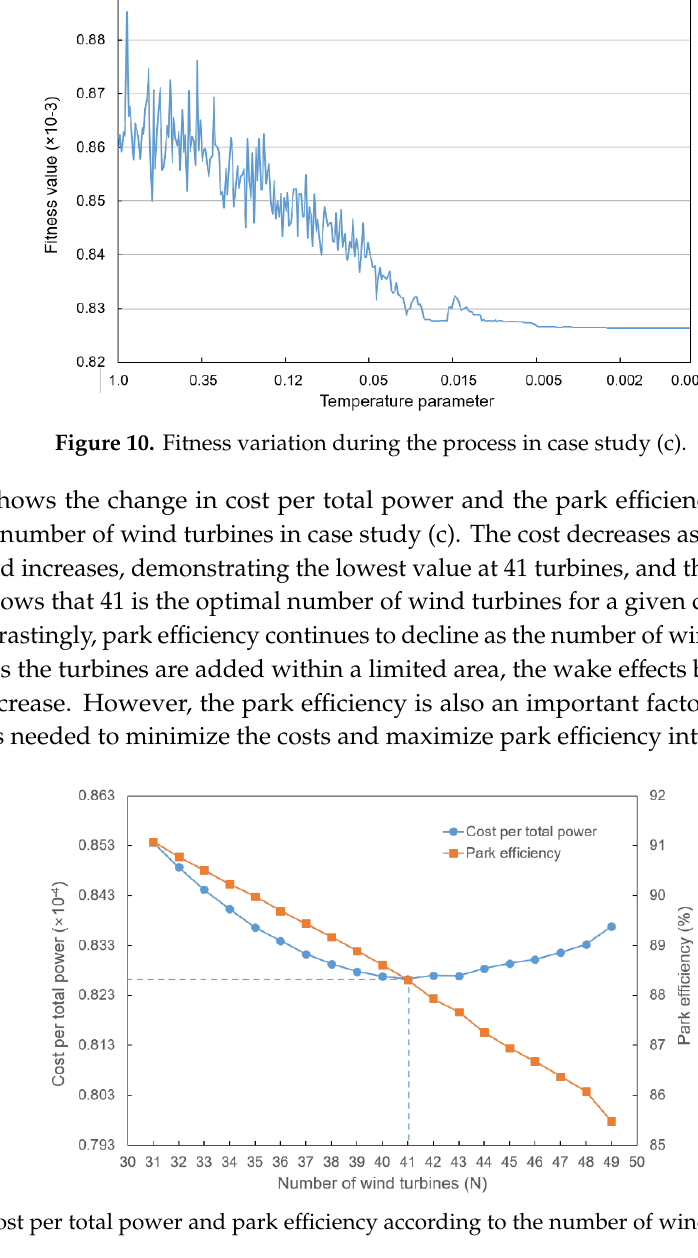
Figure 10. Fitness variation during the process in case study (c). Table 5. Layout Results for Case Study (c).